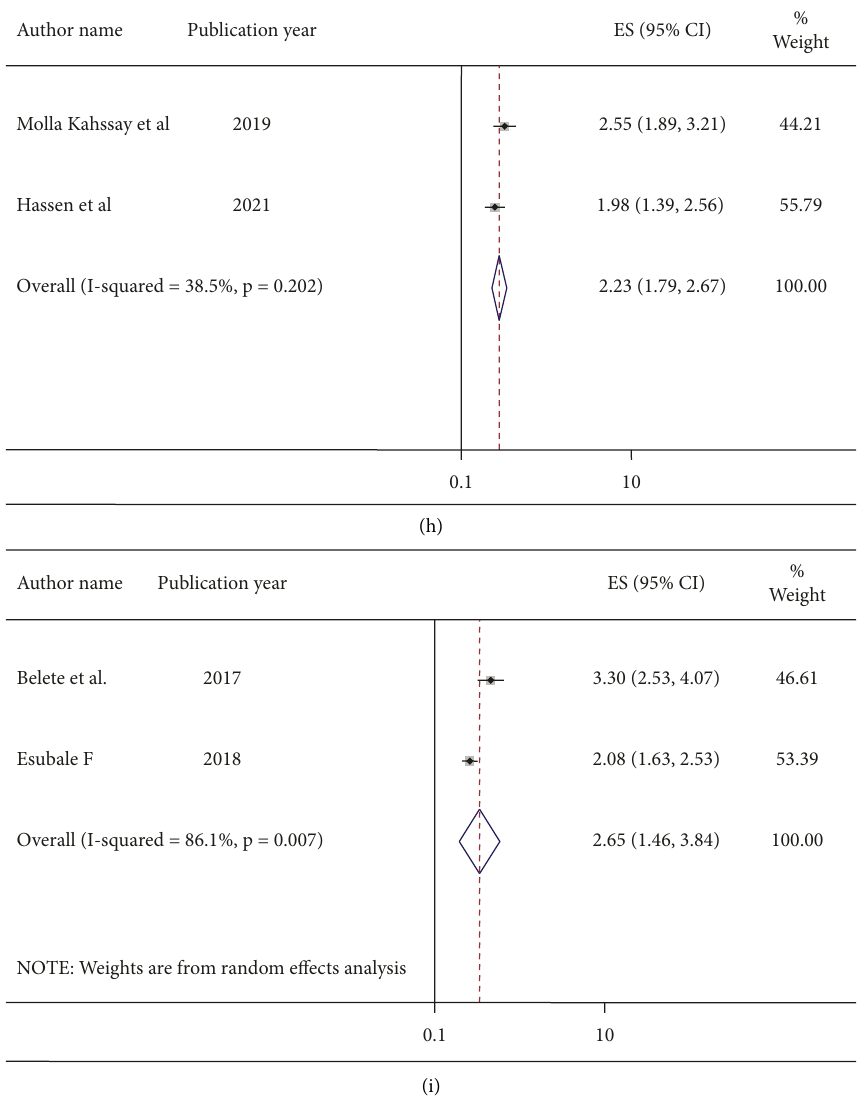
Figure 5: Forest plot displaying pooled odds ratios of the associated factors of appropriate complementary feeding practices (a) mothers’ educational status of secondary school and above, (b) repeated antenatal care visits, (c) children aged between 12 and 24 months, (d) repeated postnatal care visits, (e) health education on IYC feeding practice, (f) knowledge of mothers on IYC feeding practice, (g) maternal age between 18 and 35 years, (h) institutional delivery, and (i) higher household